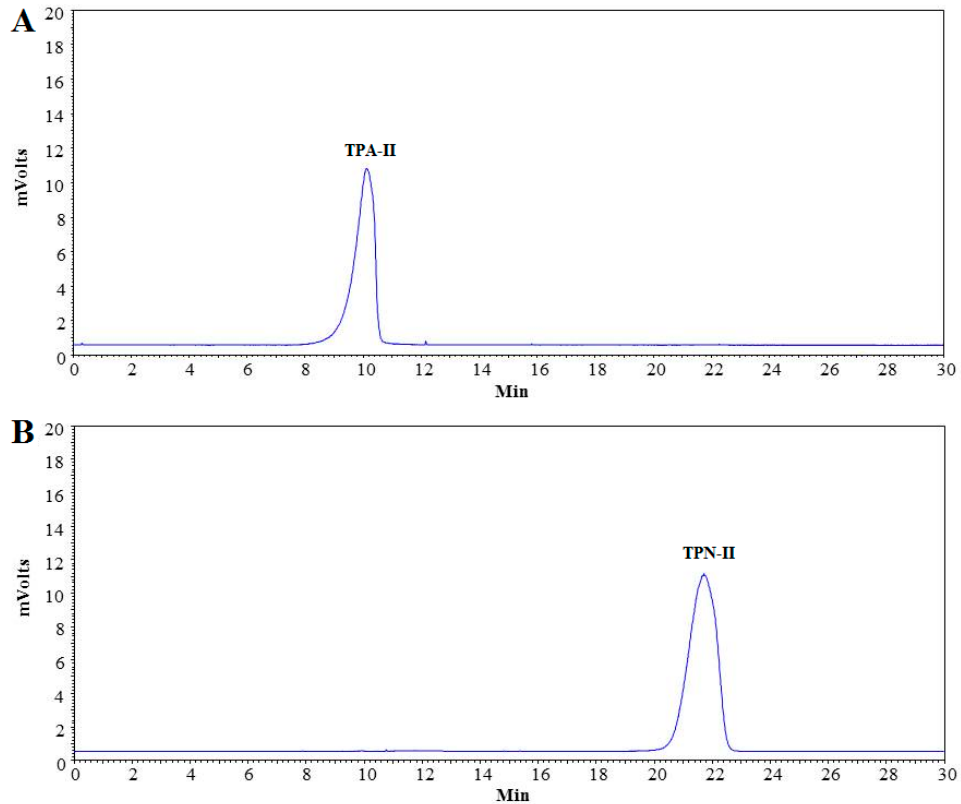
Figure 5. High performance gel permeation chromatography (HPGPC) profiles of neutral fraction of total polysaccharides-II (TPN-II) ( A ) and acidic fraction of total polysaccharides-II (TPA-II) ( B ). To further clarify the structure of TPA-II and TPN-II, fourier transform-infrared spectroscopy (FT-IR) and NMR analysis of the two purified polysaccharides were performed (the results were shown in the Supplemental Materials). Based on the results of HPLC and NMR analysis, there were great di ff erences in molecular weight, monosaccharide composition, branching degree, and content of uronic acid between TPN-II and TPA-II. Therefore, their biological activities may be varied due to the structural di ff